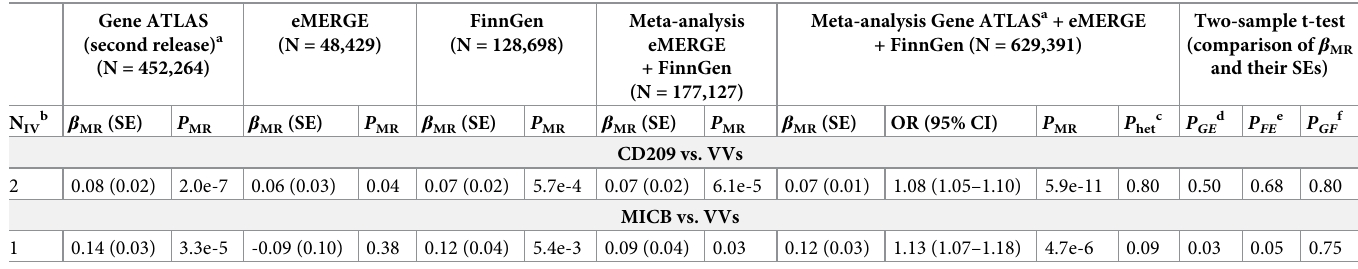
Table 1. Results of the IVW Mendelian randomization analysis of the effects of MICB and CD209 plasma levels on VVs. Gene ATLAS (second release) a